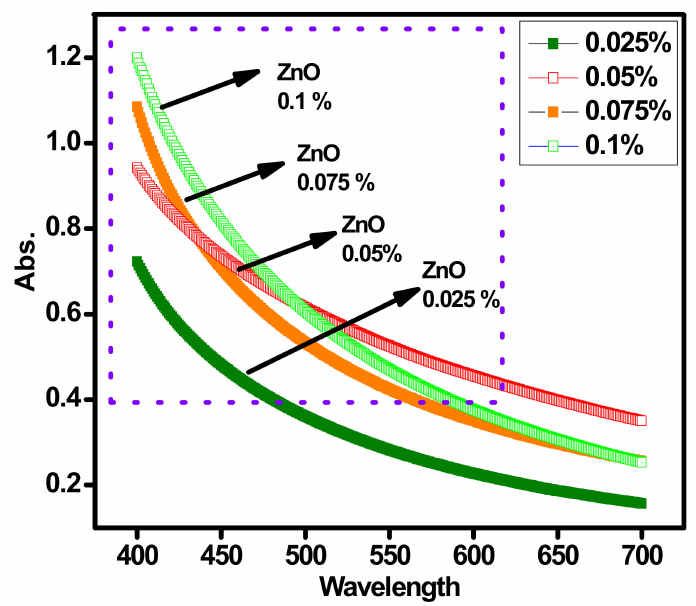
Figure 5. Absorption profile of ZnO-EG@DW nanofluids and their changed 0.1, 0.075, 0.05 and 0.025